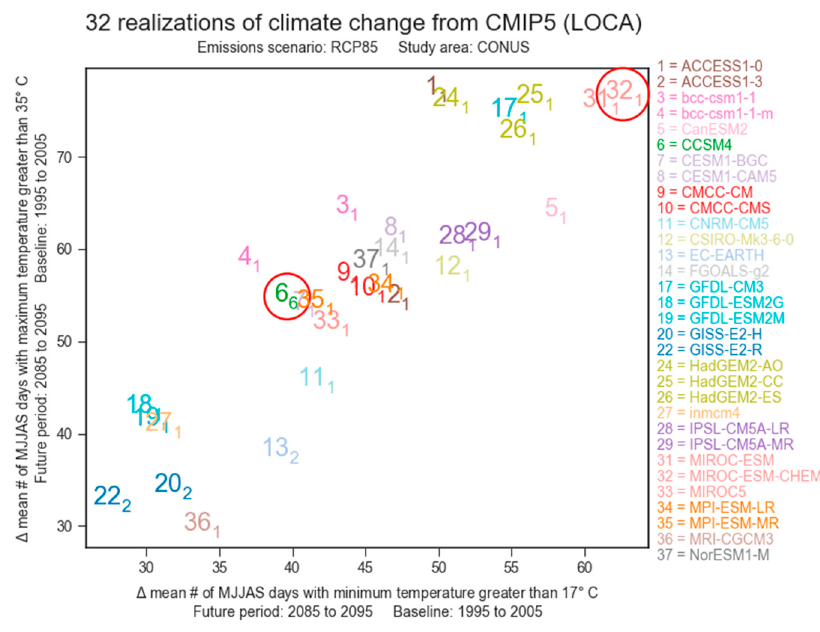
Figure 4. Locating and Selecting Scenarios Online (LASSO) scatterplot used to select climate projections. Climate models are denoted with a number shown to the right of the figure. Subscripts indicate the realization number of individual projections, i.e., some climate models produced multiple simulations. For this study, MIROC-ESM-CHEM (32 1 ) was chosen to represent the upper bound of potential temperature change. CCSM4 (6 6 ) was selected because it provided a more moderate projection of change and has been used in other recent modeling studies.